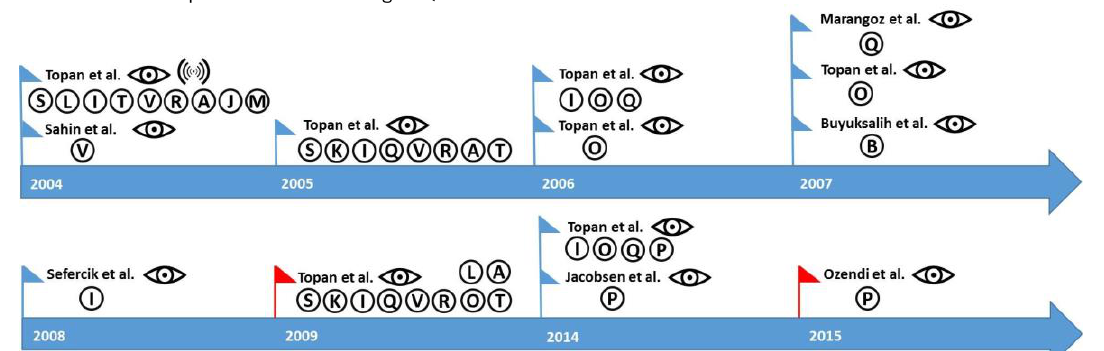
Figure 5. Summary of previous studies of information